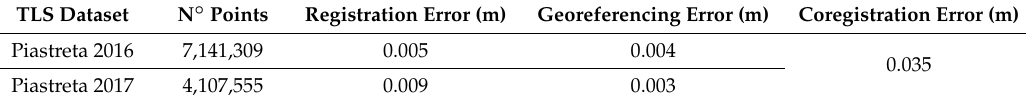
Table 1. Characteristics of the TLS datasets used for multitemporal marble extraction